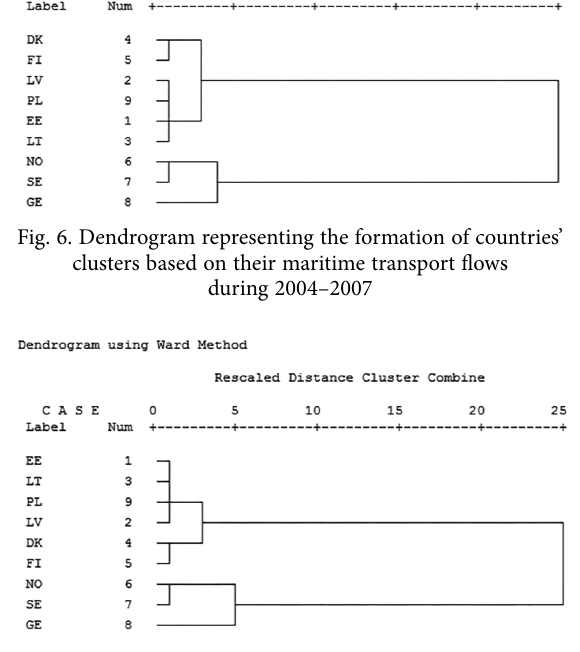
Fig. 7. Dendrogram representing the formation of countries’ clusters based on their maritime transport flows during